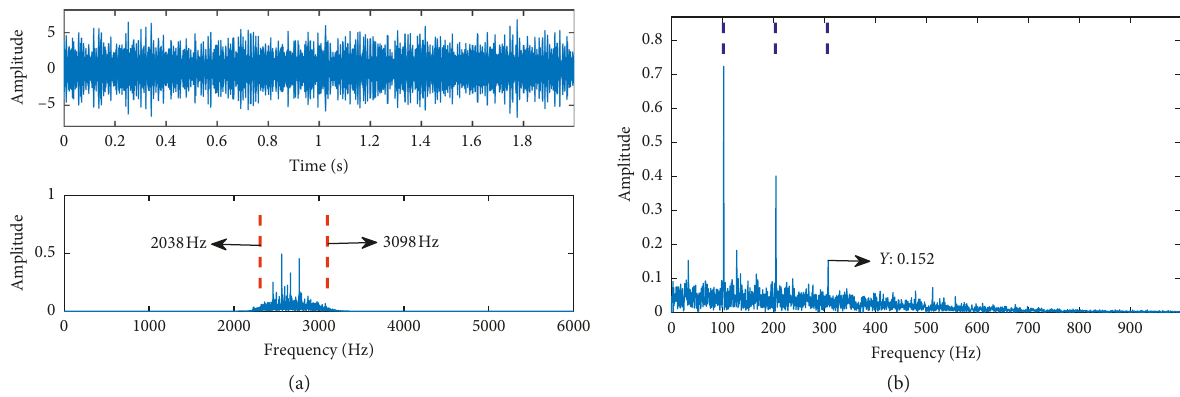
Figure 18: (a) Time-domain waveform diagram of the signal component with the maximum kurtosis found by the new method and its frequency band and (b) its envelope sequence.